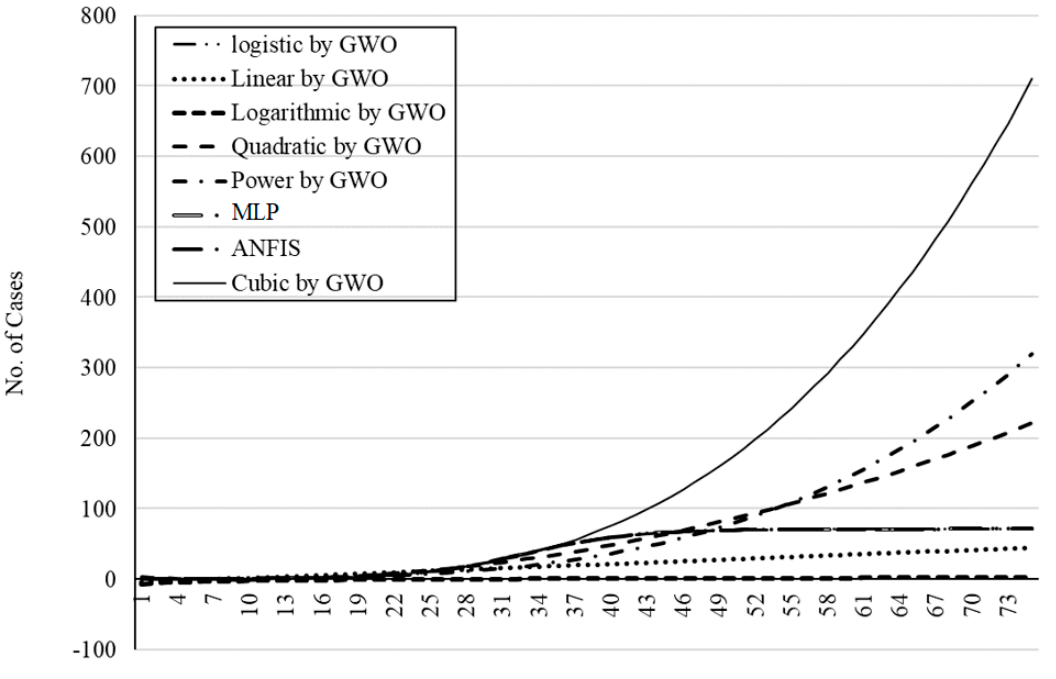
Figure 22. The outbreak prediction for Italy through 75 days.